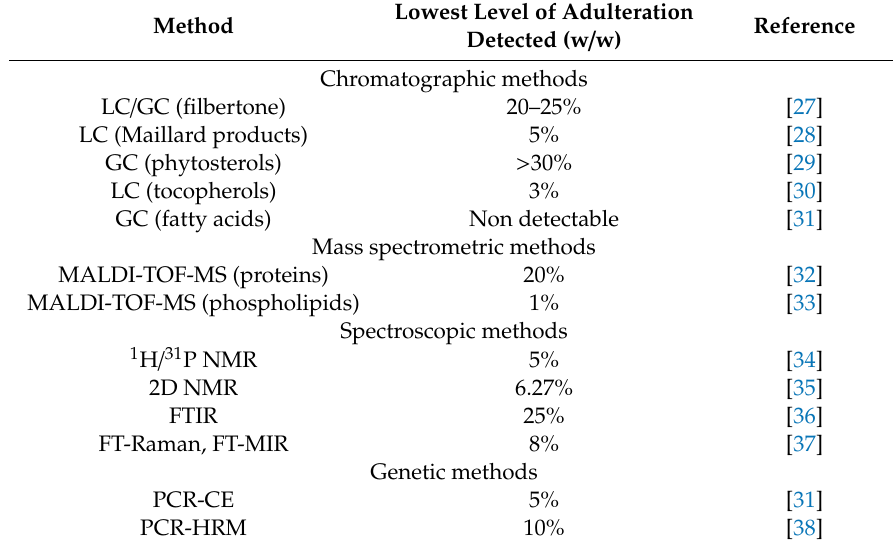
Table 2. Performance of previously published methods to detect virgin olive oil adulteration with hazelnut